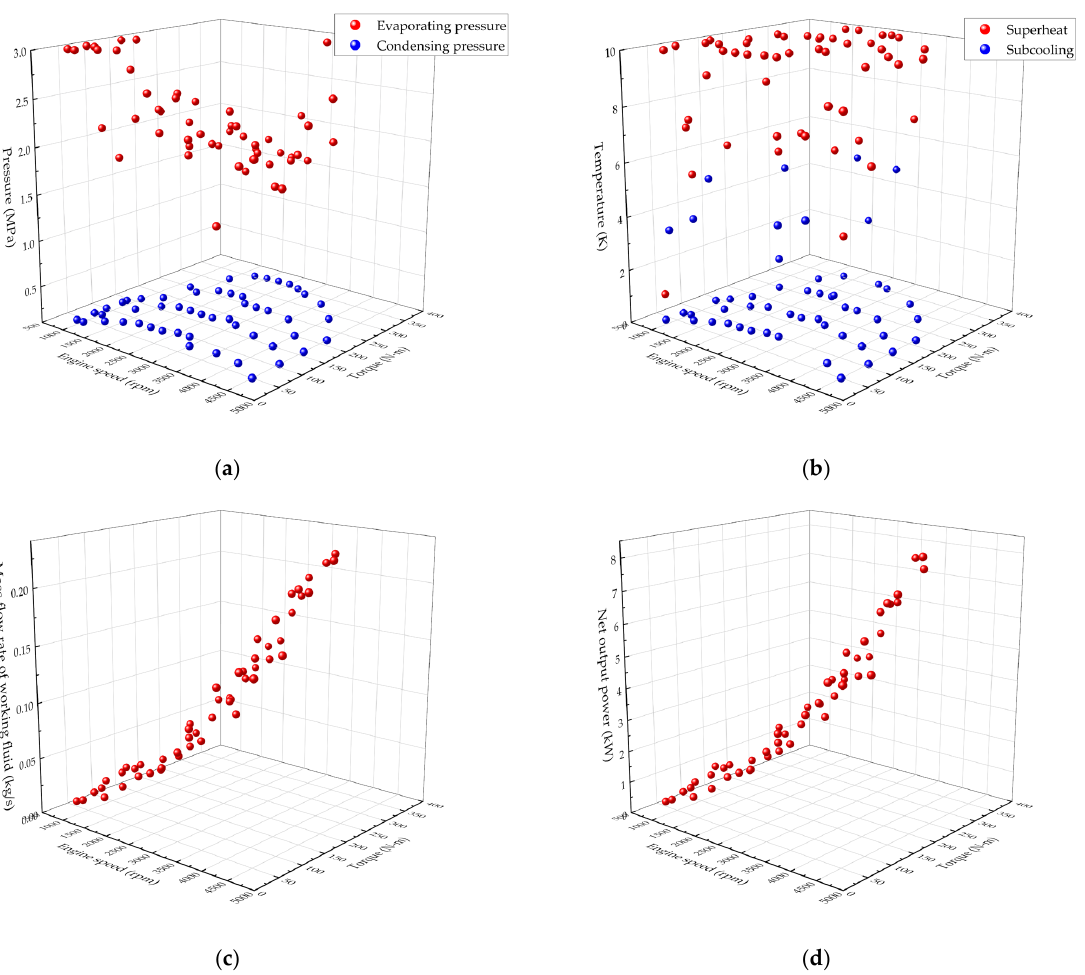
Figure 12. The effect of the multi-operating conditions optimization results: ( a ) evaporating and condensing pressure; ( b ) the degree of superheat and subcooling; ( c ) mass flow rate of working fluid; ( d ) ORC net output power.